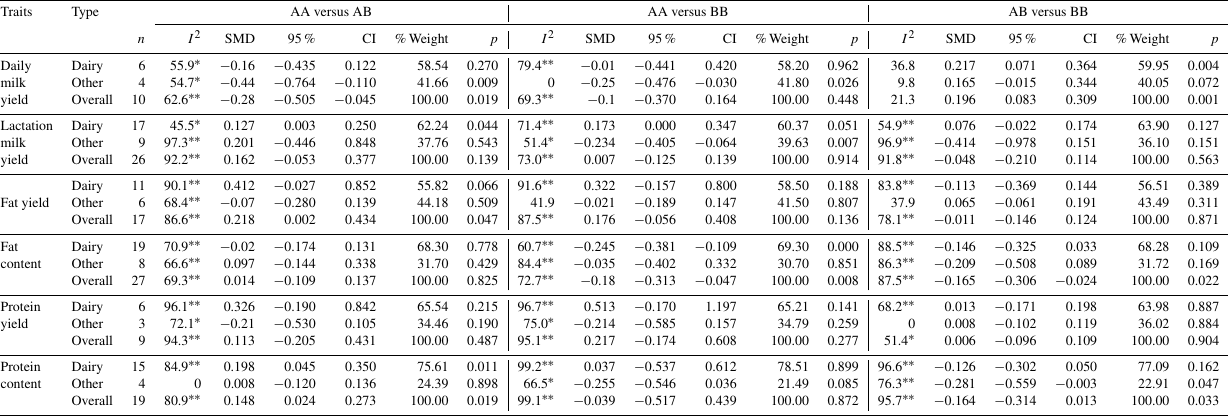
Table 3. Results of the meta-analysis on the associations among BLG genotypes and milk production traits, SMD values, and level of significance.